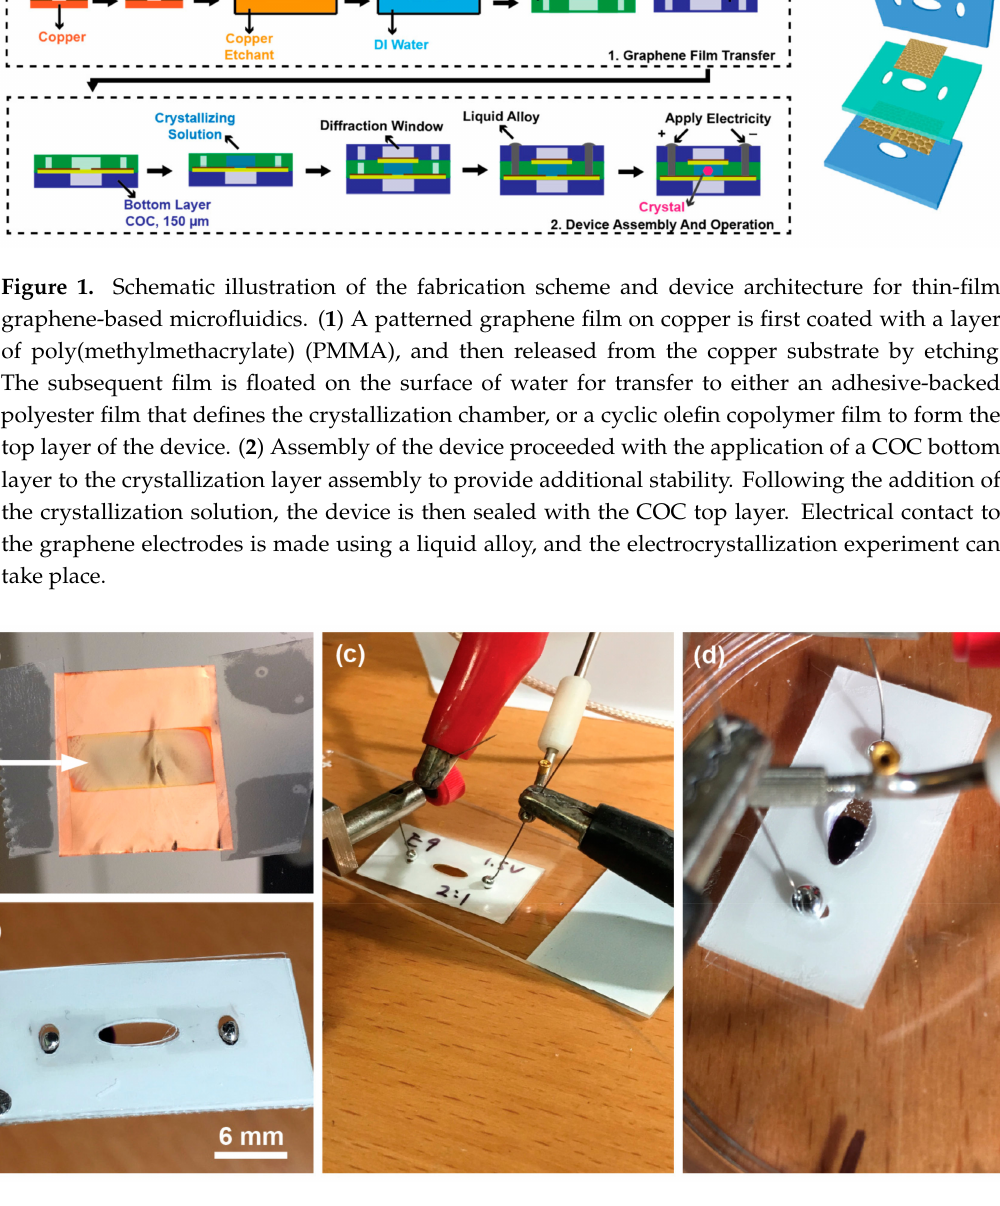
Figure 2. ( a ) Graphene film on copper growth substrate after oxygen plasma treating. The brassy yellow area in the middle of the film was exposed to the plasma, while the upper and lower regions were covered and protected by a mask created from thermal release tape. ( b ) A view of the patterned electrodes (regions of light grey) in an assembled device. ( c ) System setup for electrocrystallization experiments. Alligator clips attached to metal needles and gallium–indium alloy droplets were used to make electrical contact with the integrated graphene electrodes. ( d ) The presence of an applied electric field can be observed visually based on the color change of methyl viologen from clear to purple as it undergoes reduction at the